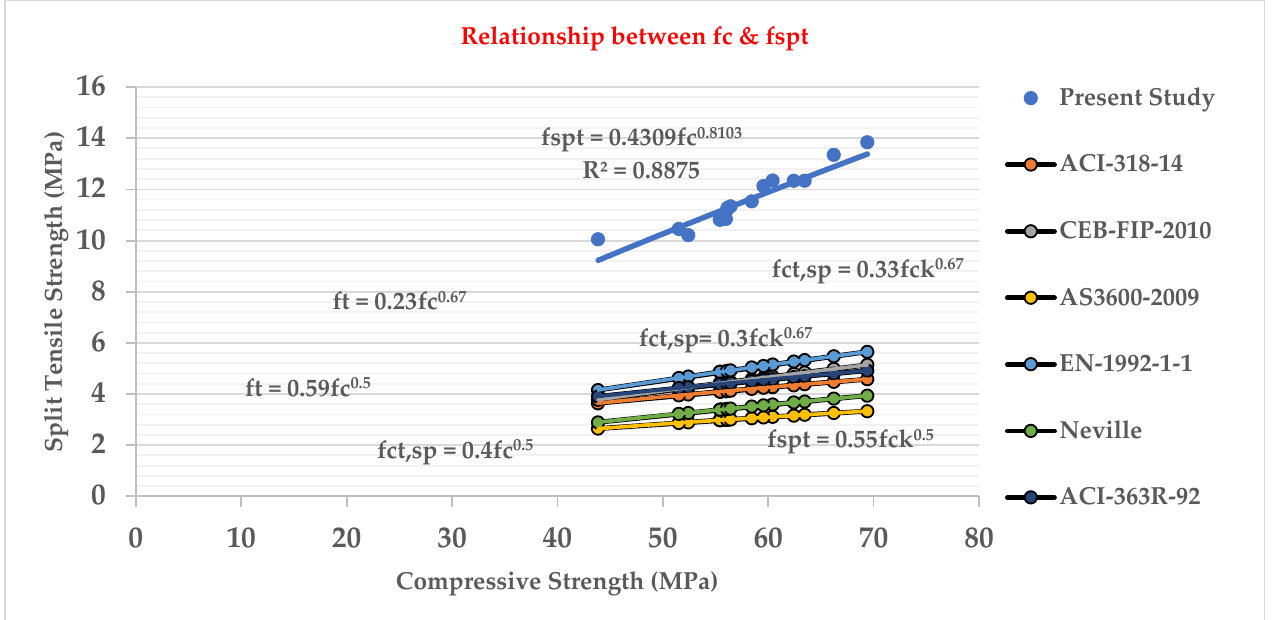
Figure 10. Relation between split tensile strength and compressive strength.